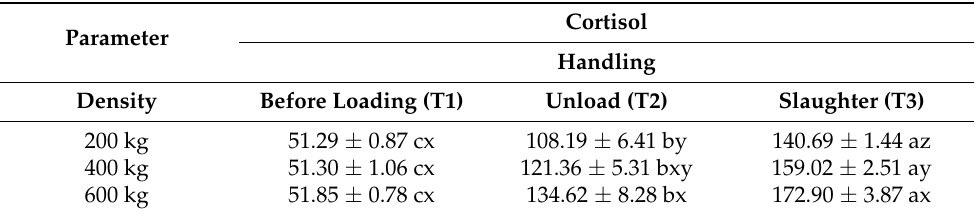
Table 5. Cortisol, as influenced by the interaction between handling and stocking density in Brahman crossbred cattle.